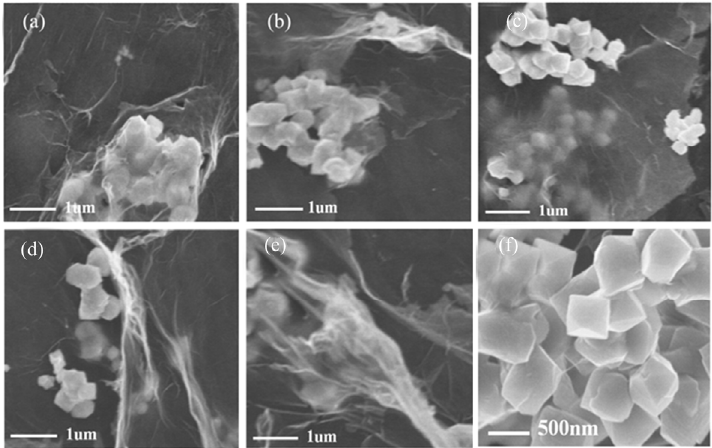
Figure 4. TEM images of 3D BFO/graphene composites: ( a ) B-3D1; ( b ) B-3D2; ( c ) B-3D3; ( d ) B-3D4; ( e ) B-3D5; ( f ) B-3D3.